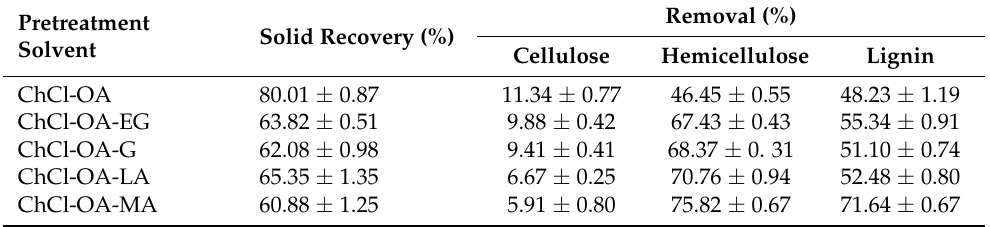
Table 2. Effect of various pretreatment solvents on the chemical composition of